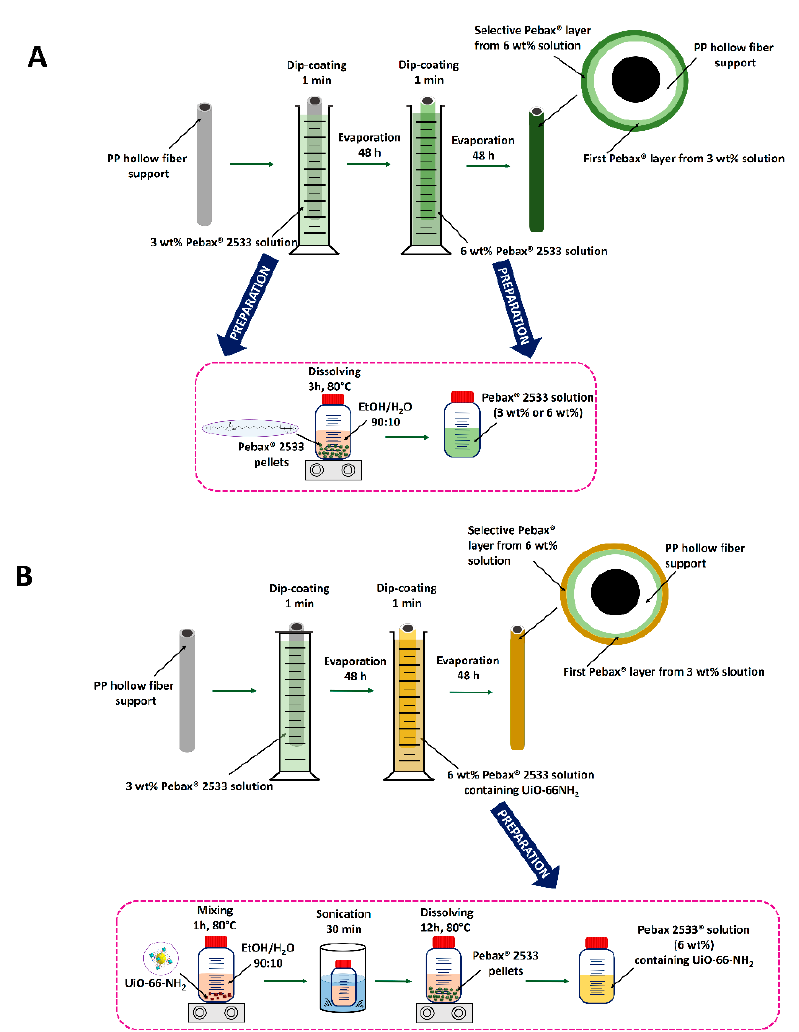
Figure 1. Schematic illustration of the preparation pristine Pebax ® 2533 thin film hollow fiber membrane ( A ) and Pebax ® 2533-UiO-66-NH 2 /PP mixed matrix thin film hollow fiber membrane ( B ).